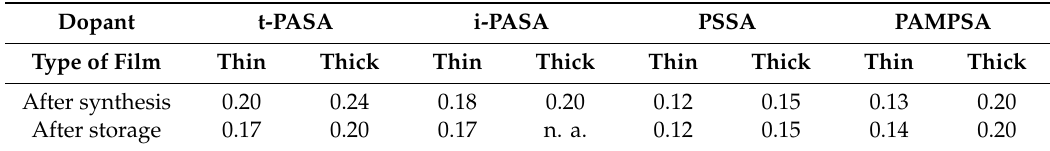
Table 2. Redox numbers obtained from electrochemical data after synthesis and after long-term storage in the dry